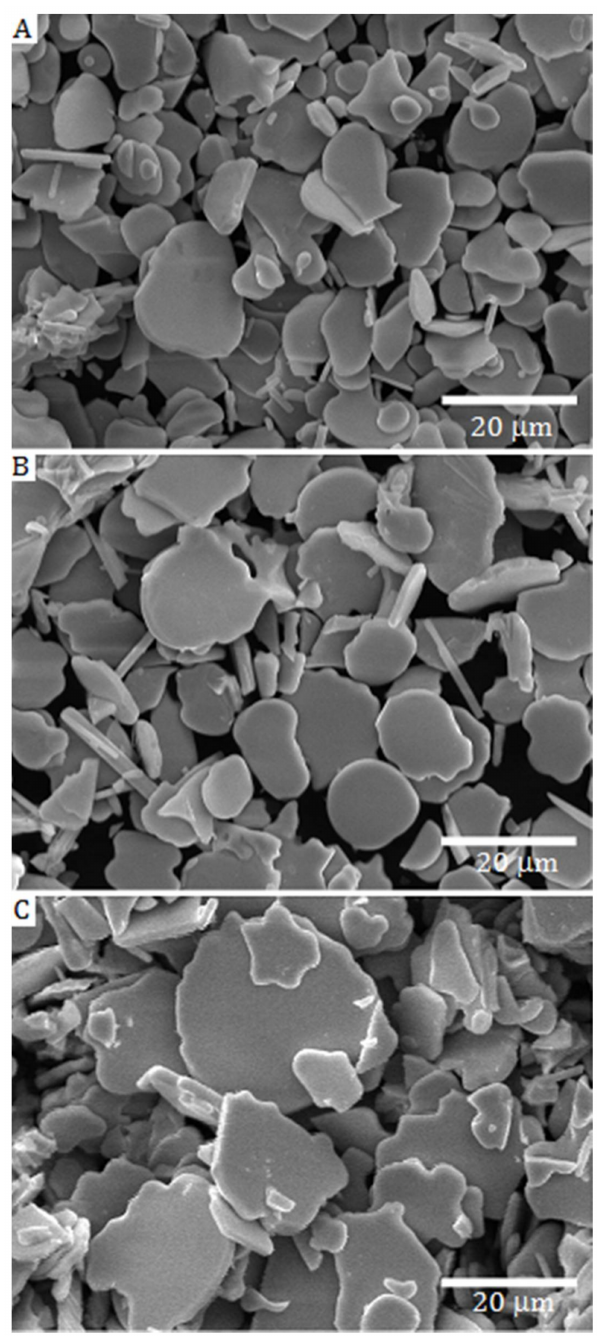
Figure 5. SEM images of BICUTIVOX platelets formed by MSS at: ( A ) 650 ◦ C/8 h, ( B ) 675 ◦ C/8 h, ( C ) 700 ◦ C/8